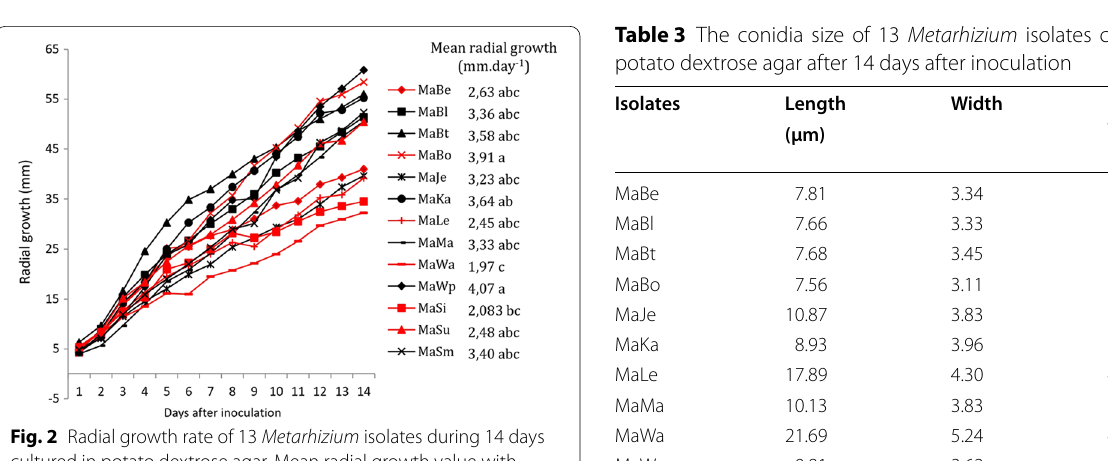
Table 3 The conidia size of 13 Metarhizium isolates cultured in potato dextrose agar after 14 days after inoculation Isolates Length